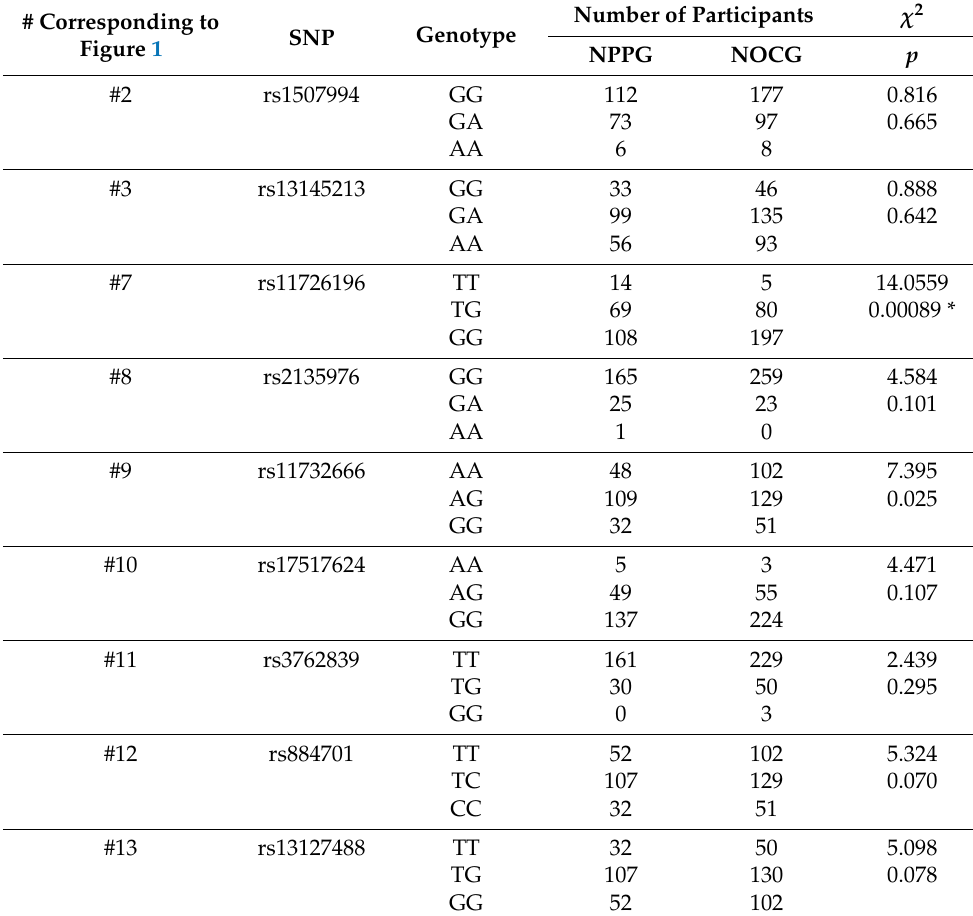
Table 2. Associations between the tag SNPs in and around the TRPC3 gene and chronic pain, comparing the genotype distributions between patients and control